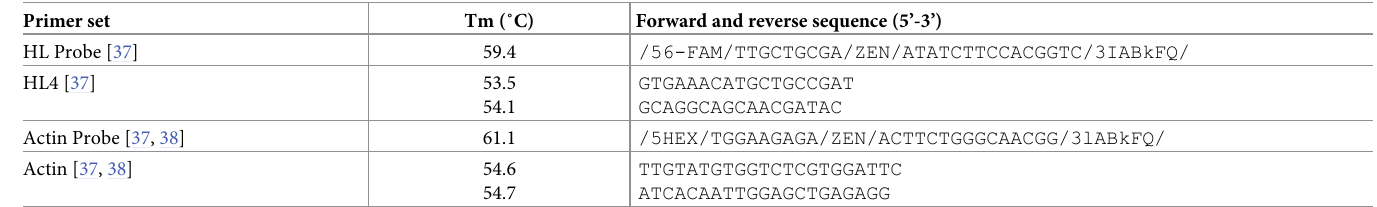
Table 1. Primer sets and probes for Xylella fastidiosa HL and pecan actin used for qPCR reactions. Primer set